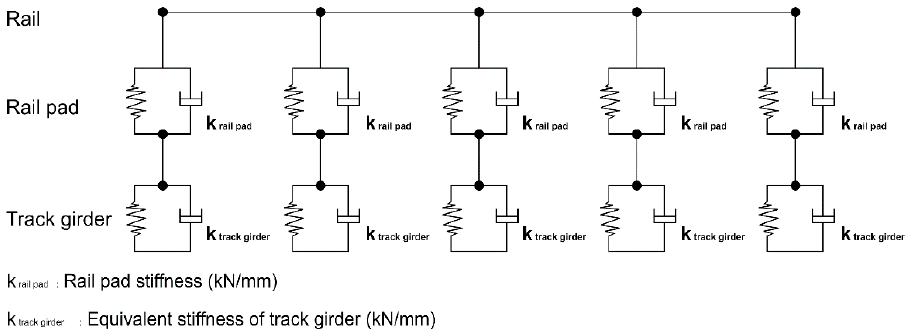
Figure 13. Spring stiffness model of a direct fixation track at the rail supporting points [2].